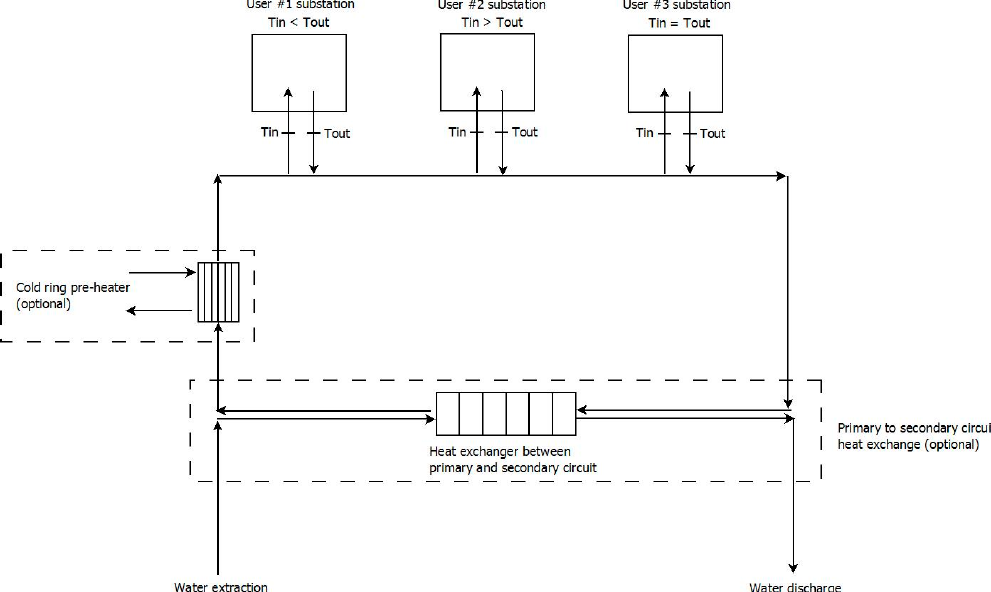
Figure 1. Cold district heating and cooling network. The scheme includes the primary-secondary circuit option, as well as the possibility to pre-heat the water flowing through the cold ring. A CDH network can be seen as a water-loop heat pump (WLHP) system developed at district